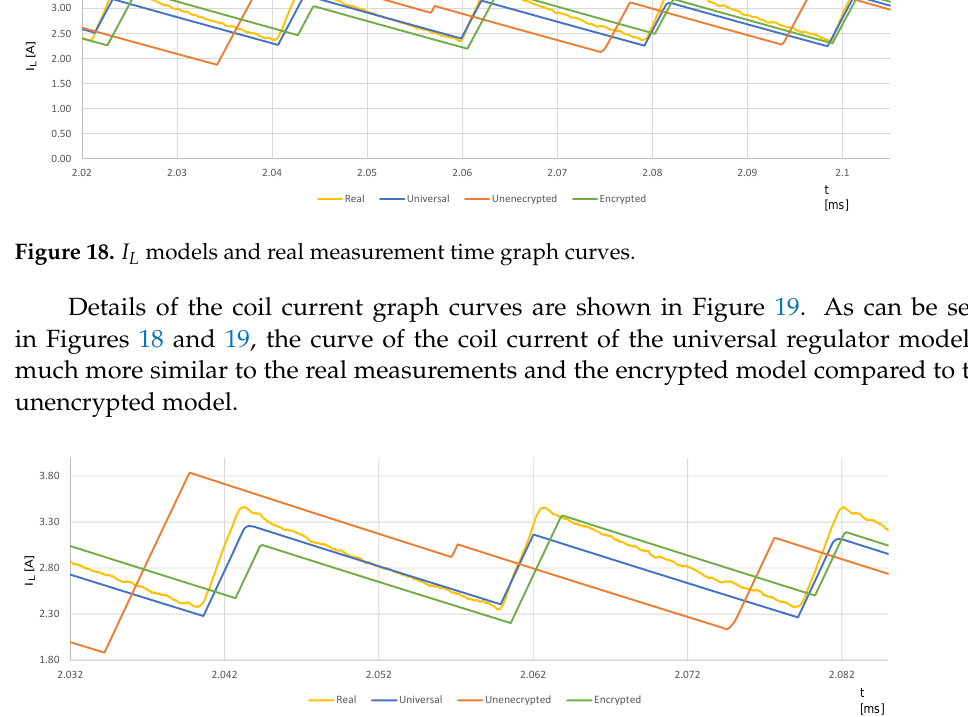
Figure 19. Detailed I L models and real measurement time graph curves where value of I L is in Amperes and time is in ms.